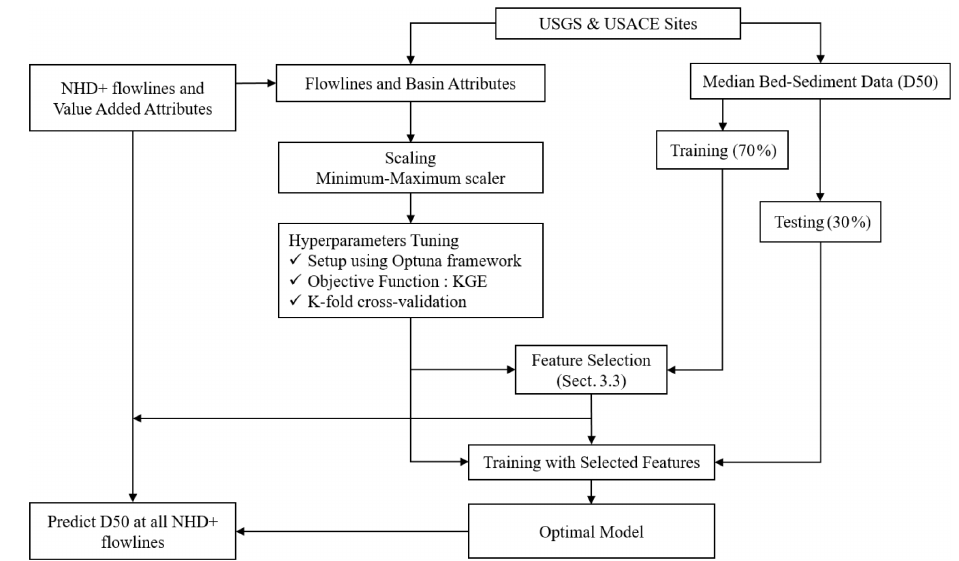
Figure 3. Flowchart for XGBoost training and